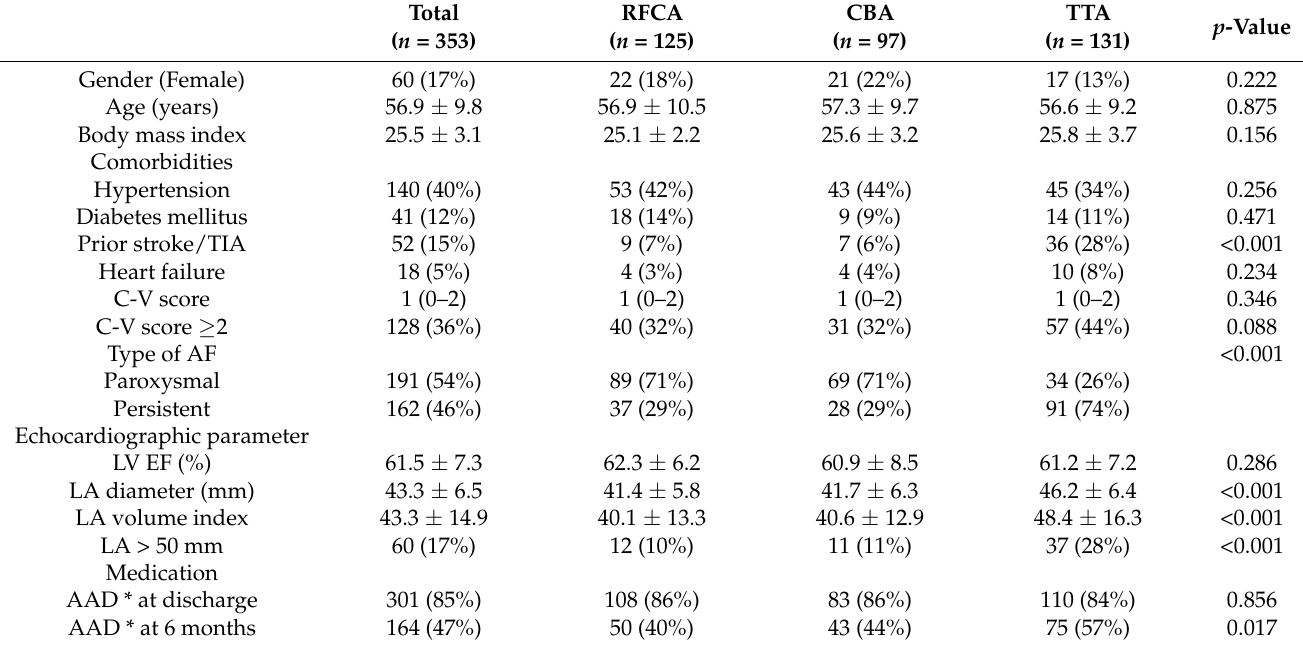
Table 1. Baseline